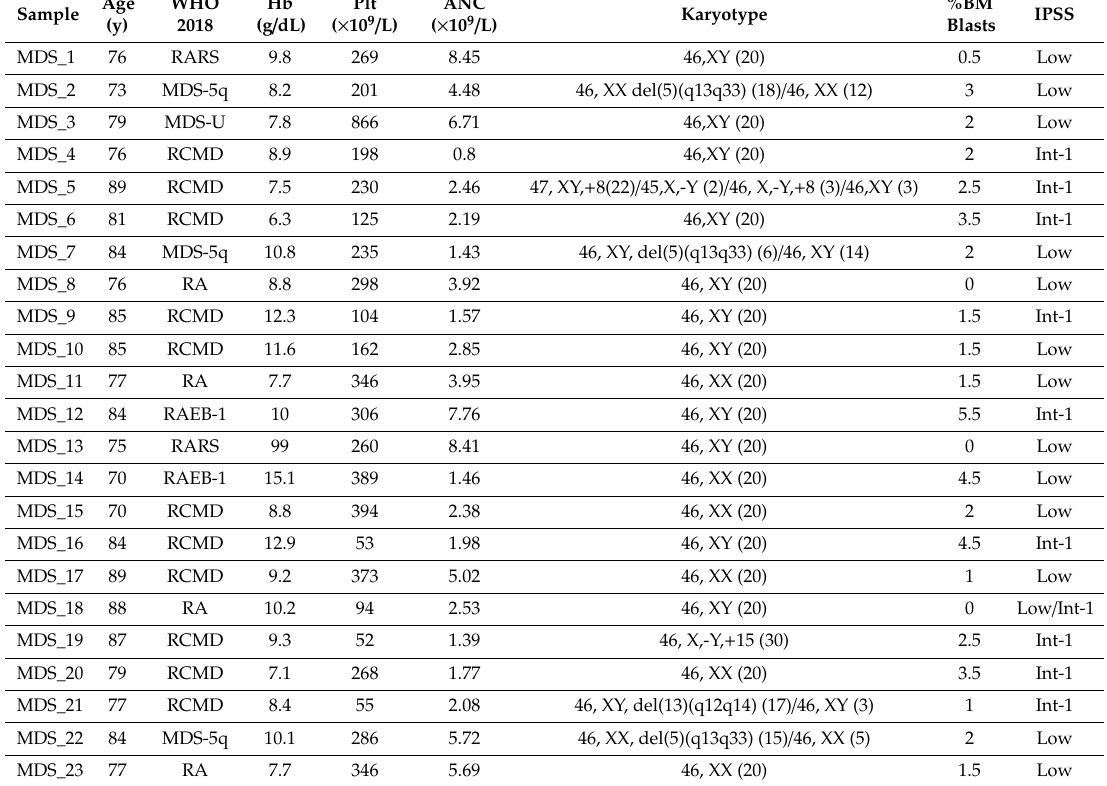
Table 1. Biological and clinical characteristics of the myelodysplastic syndrome (MDS) patients included in this